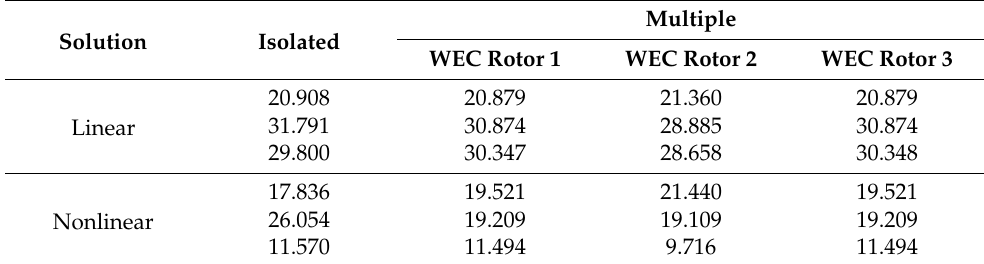
Table 5. Comparison of time-averaged optimum extracted power P opt in kW of isolated and multiple WEC rotors for different wave frequencies